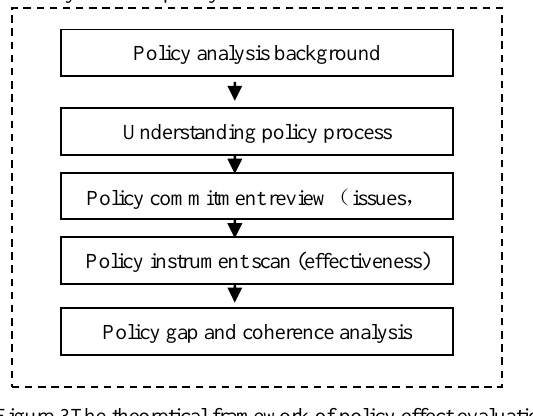
Figure 3The theoretical framework of policy effect